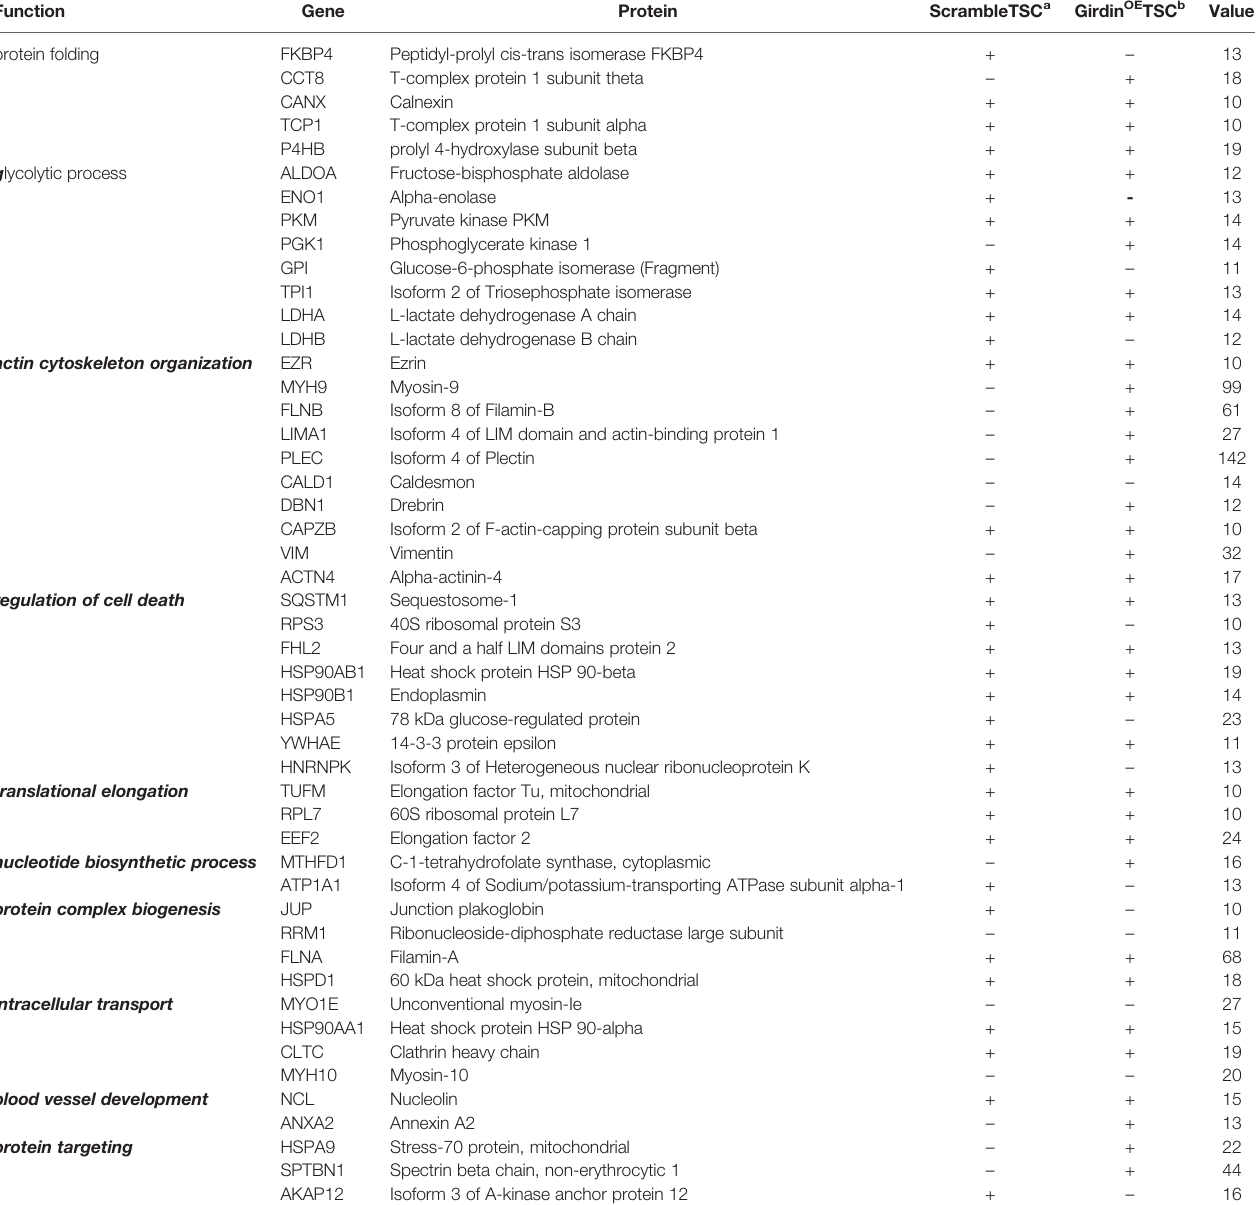
TABLE 1 | Analysis of protein interaction about Girdin in MS. Function Gene protein